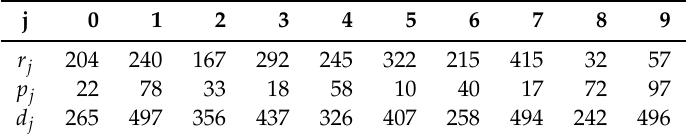
Table 5. A problem instance N_3_10 for which kernel K ( σ ) collapses.